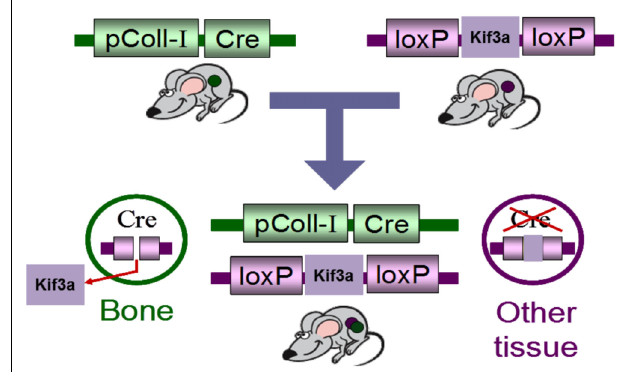
FIGURE 3 | Schematic of the Cre-lox system used to generate of bone specific primary cilium knockout